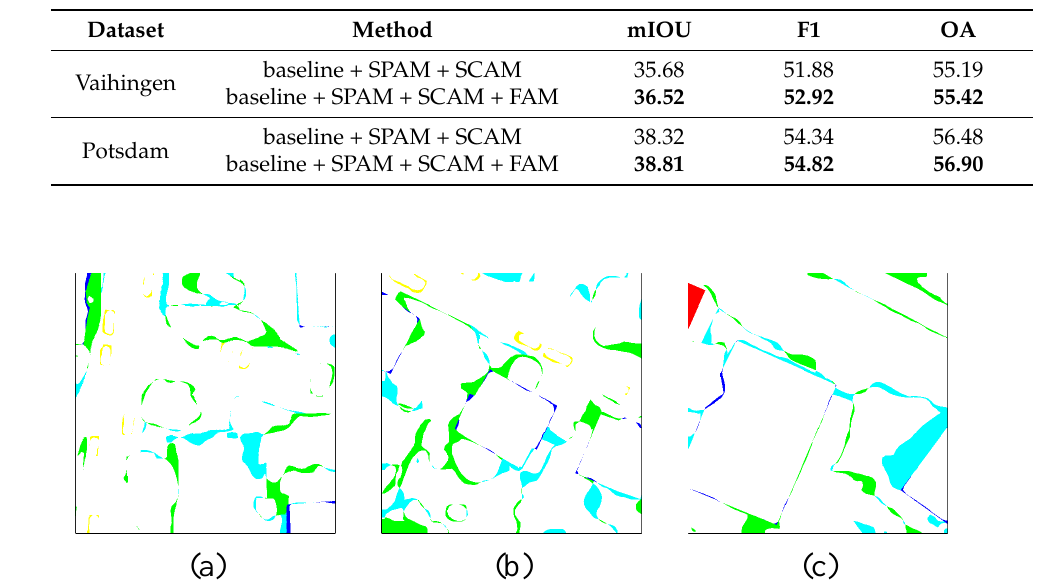
Table 7. Quantitative results achieved by different variants of our network on boundaries. The best results are shown in boldface.